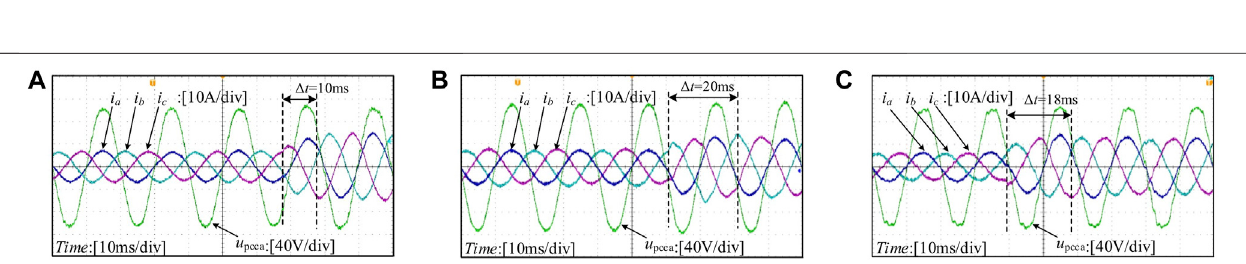
FIGURE10| Steady-stateexperimentalwaveformsoftheinverterat L g (cid:1) 3 mH: (A) withtheproposedmethodinthispaper, (B) withthemethodinLiuetal.(2020), and (C) with the method in Jiao and Lee (2015).